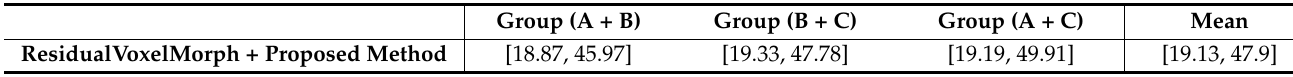
Table 2. The range of the loss function values for the validation